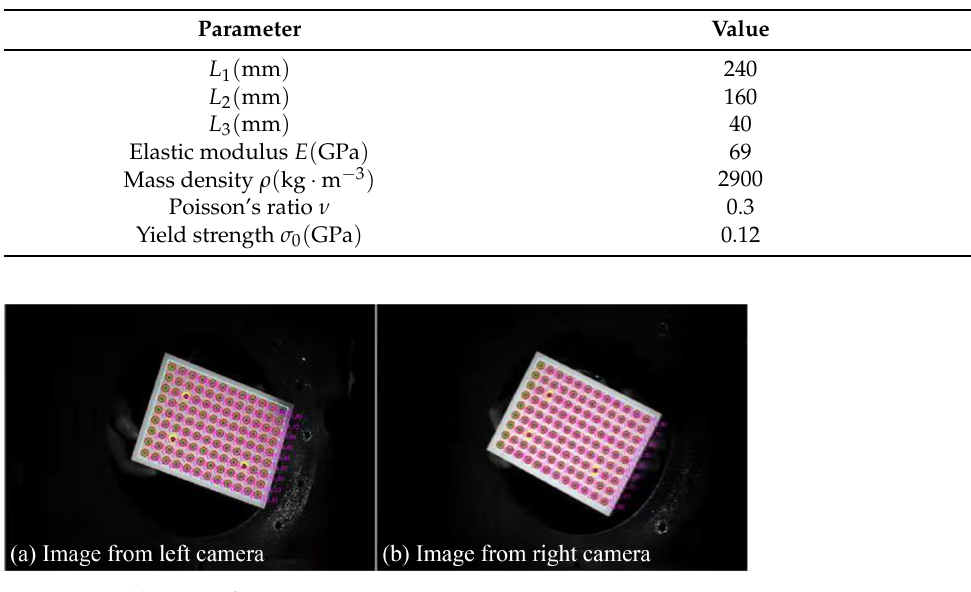
Figure 3. Calibration of DIC measurements.